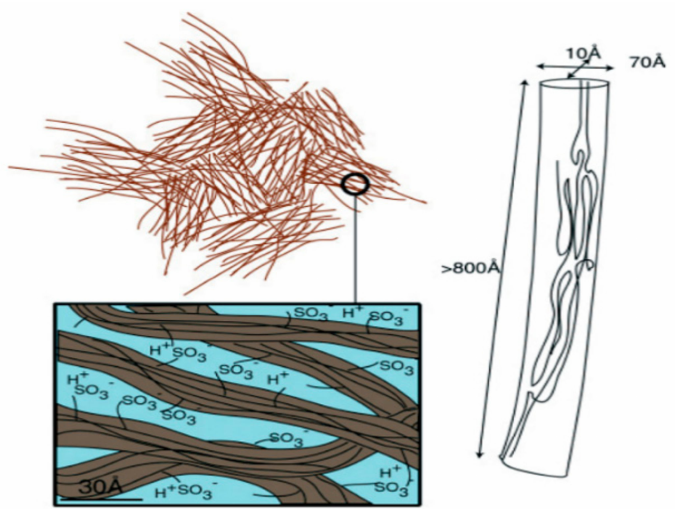
Figure 2. New insight of a Nafion membrane multiscale structure (adapted from [95]).